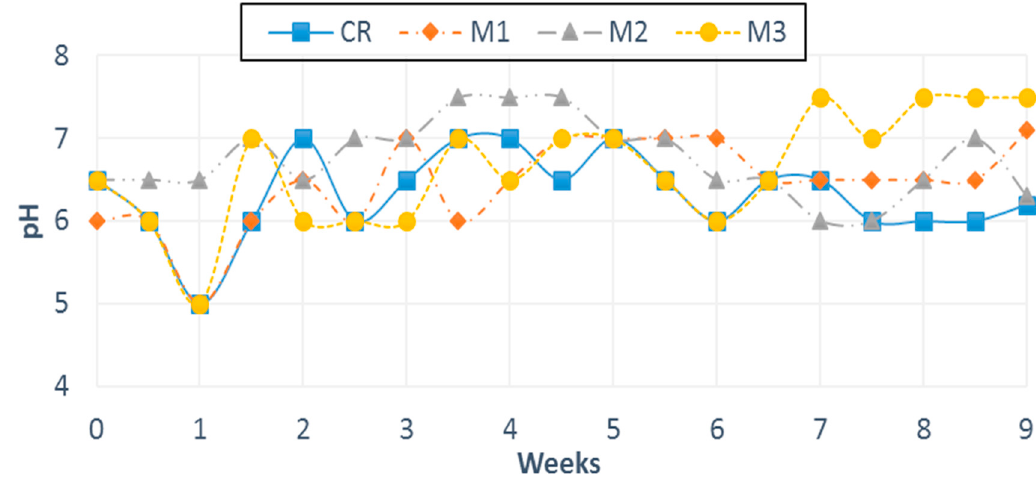
Figure 6. pH behavior of mixes during the vermicomposting process.